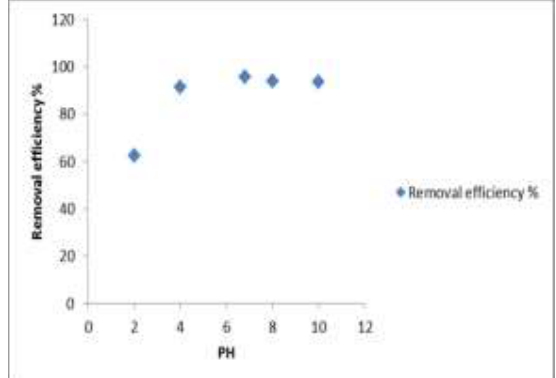
Fig.5: Effect of pH on the removal efficiency